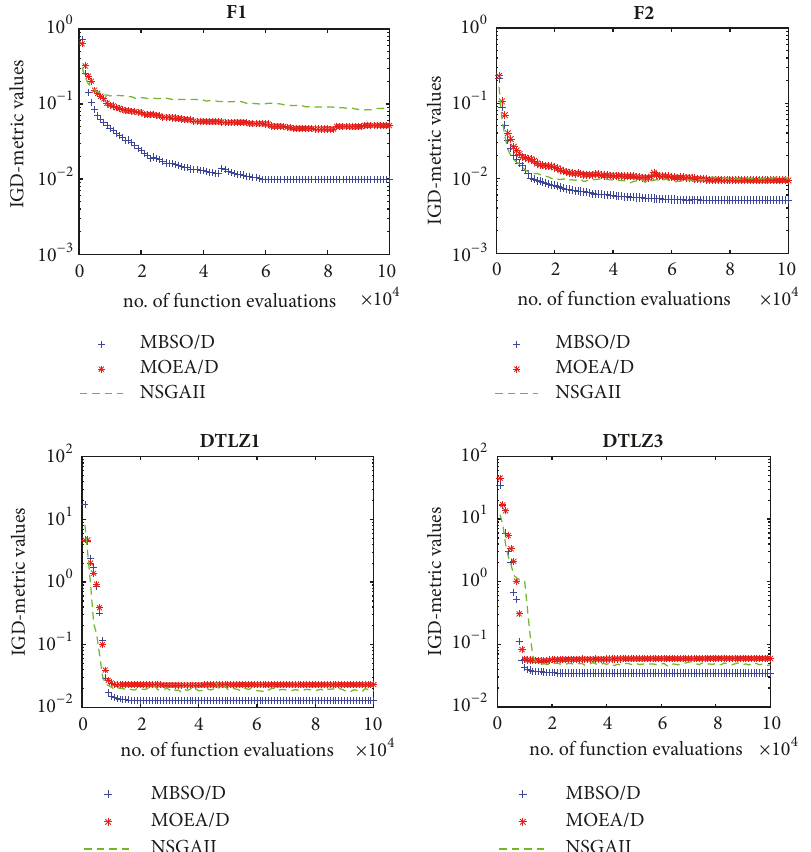
Figure 2: Evolution of the mean of IGD metric values for F1, F2, DTLZ1, and DTLZ3.